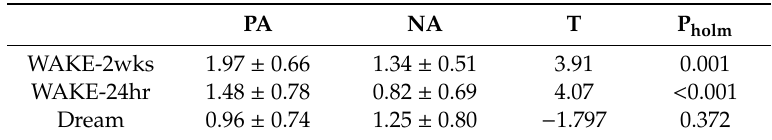
Figure 3. Change in mDES scores as a function of Condition (WAKE-2wks, WAKE-24hr, and Dream) and Valence (Positive and Negative). Error bars represent standard error of the means. Table 1. Mean ± SD of Positive and Negative Affect scores of the WAKE-2wks, WAKE-24hr, and Dream mDES.